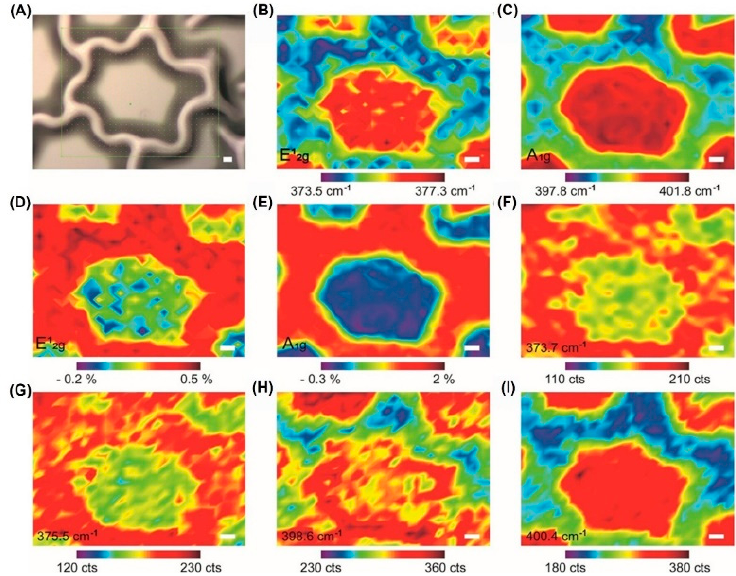
Figure 6. Native strain variations in MoS 2 web buckles. ( A ) Optical image of MoS 2 web buckles. ( B , C ) Raman position mapping in the E 12g and A 1g modes. ( D , E ) Strain mapping of MoS 2 web buckles is estimated by the response of Raman-active modes to the applied biaxial strain for single-layer MoS 2 . ( F – I ) Raman intensity mapping in E 12g (between 373.7 cm − 1 and 375.5 cm − 1 ) and A 1g (between 398.6 cm − 1 and 400.4 cm − 1 ). Scale bars: 5 µm. (Reprinted/adapted with permission from Ref. [72]. Copyright 2020, American Institute of Physics).